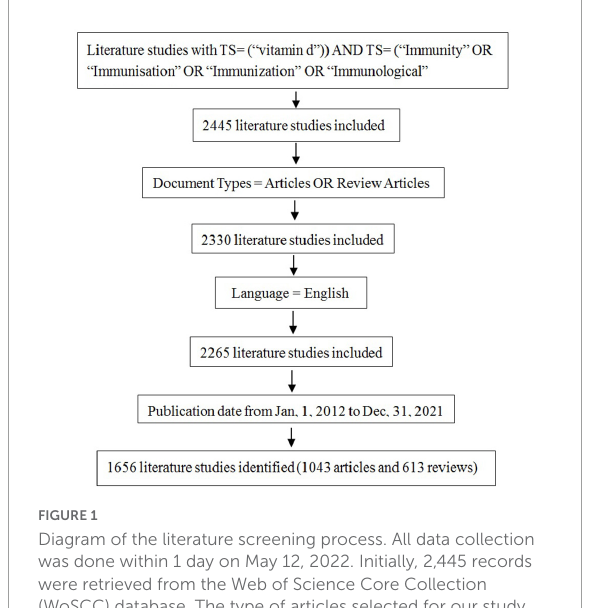
FIGURE1 Diagram of the literature screening process. All data collection was done within 1 day on May 12, 2022. Initially, 2,445 records were retrieved from the Web of Science Core Collection (WoSCC) database. The type of articles selected for our study was limited to ARTICLE and REVIEW, and the language was limited to English. The time was set from 2012 to 2021. The final 1,656 data were